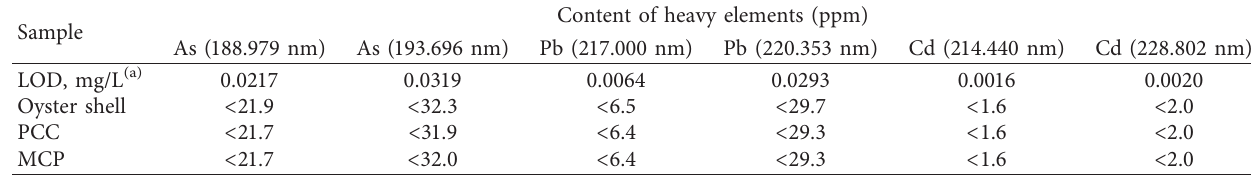
Table 1: Upper limits for the As, Pb, and Cd contents in the solid samples derived from the LOD in the solutions. Sample